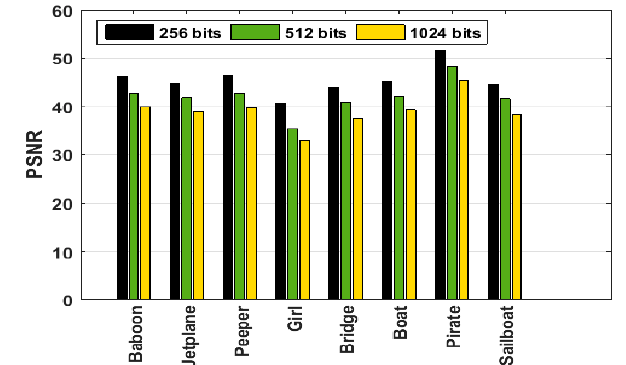
Figure 7. PSNR (dB) with different bit lengths as random bit sequences using α = 0.1.